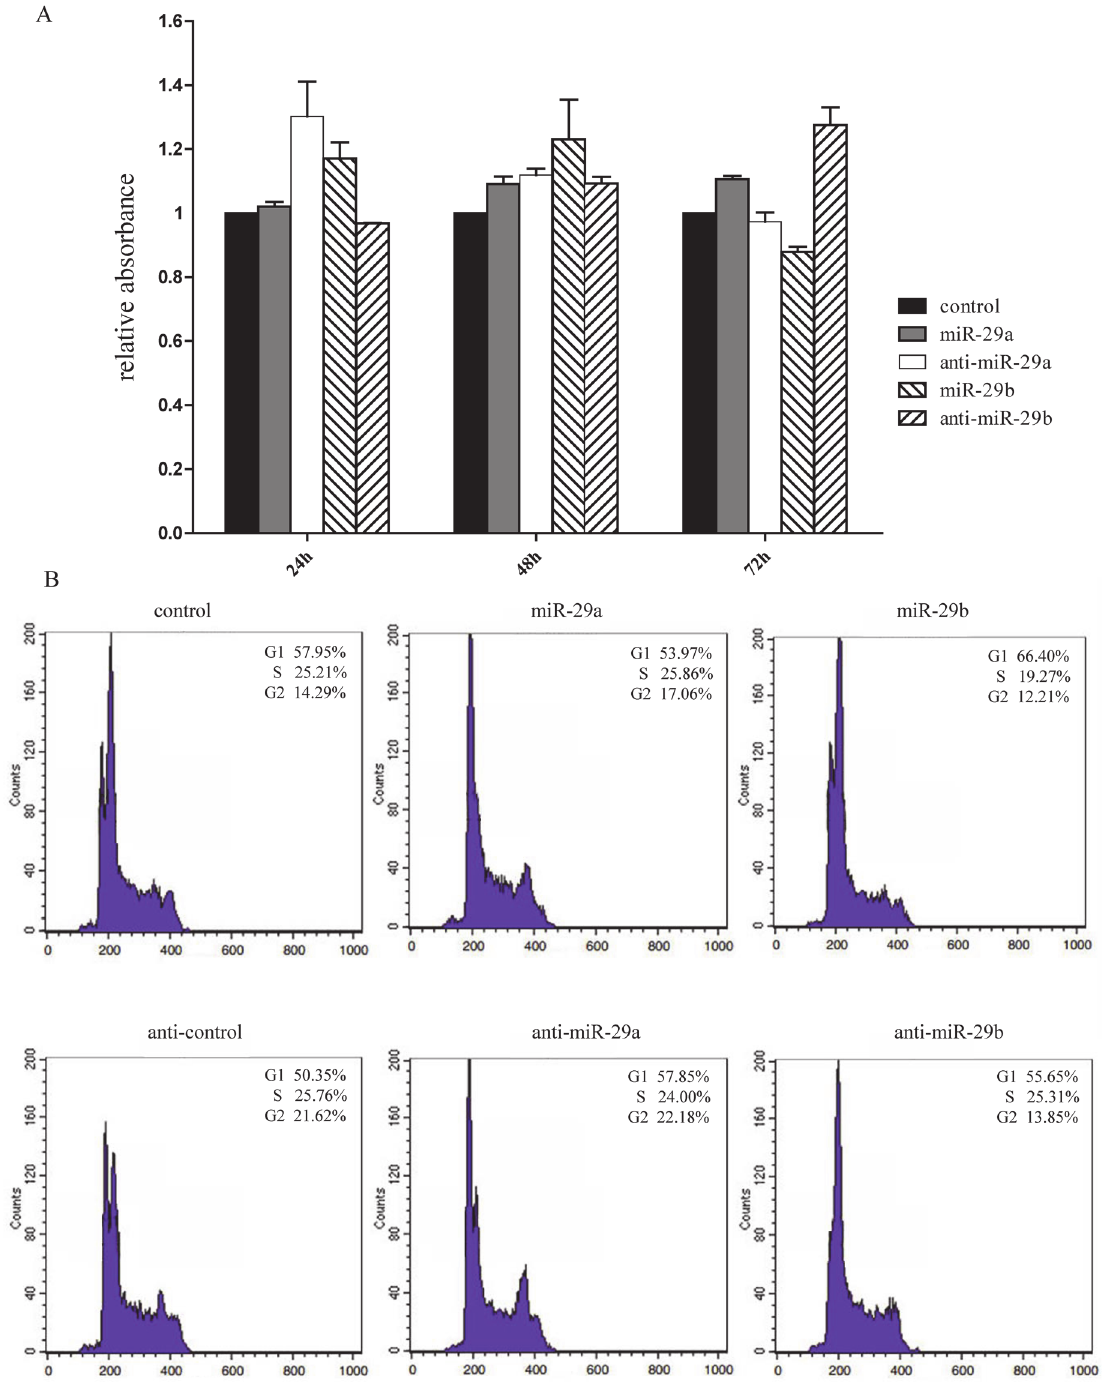
Fig 3. Effects of miR-29a/b on NPC cell growth and cell cycle. The results of MTT assays following transfection of pre-miR-29a/b and their inhibitors into S18 cells for the indicated 24 h, 48 h and 72 h post-transfection times. The values are the mean and SD optical density (OD) units. (B) miR-29b increased the proportion of S18 cells at the G1/S transition, whereas miR-29a did not have a similar effect. Cells were treated with pEGFP-miR-29a/b or anti-miR-29a/b transfection and control vector pEGPF-C. Cell cycle distributions were detected 20 h later. A representative result of 3 independent experiments is shown. In all experiments, the negative control was pre-miRNA negative